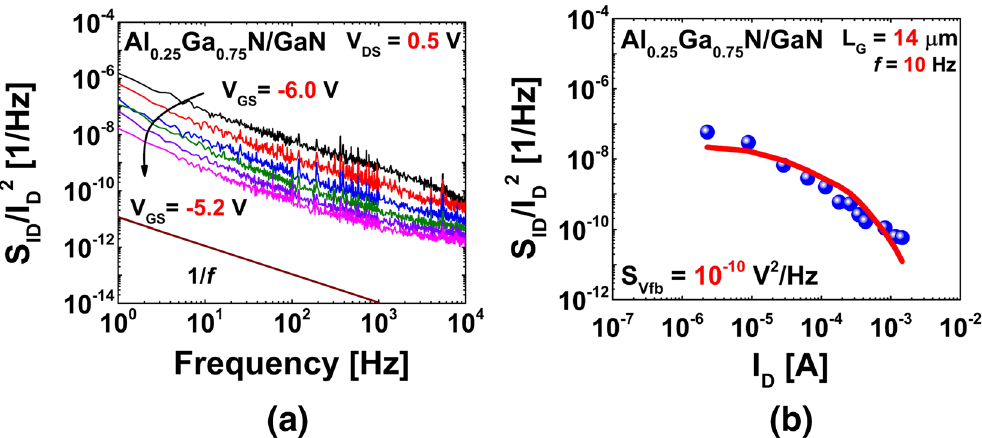
Figure 5. ( a ) Noise spectral density ( S ID / I D 2 ) with respect to frequency at various gate bias ( V GS ) points. ( b ) Noise spectral density ( S ID / I D 2 ) and ( g m / I D ) 2 as functions of drain current I D